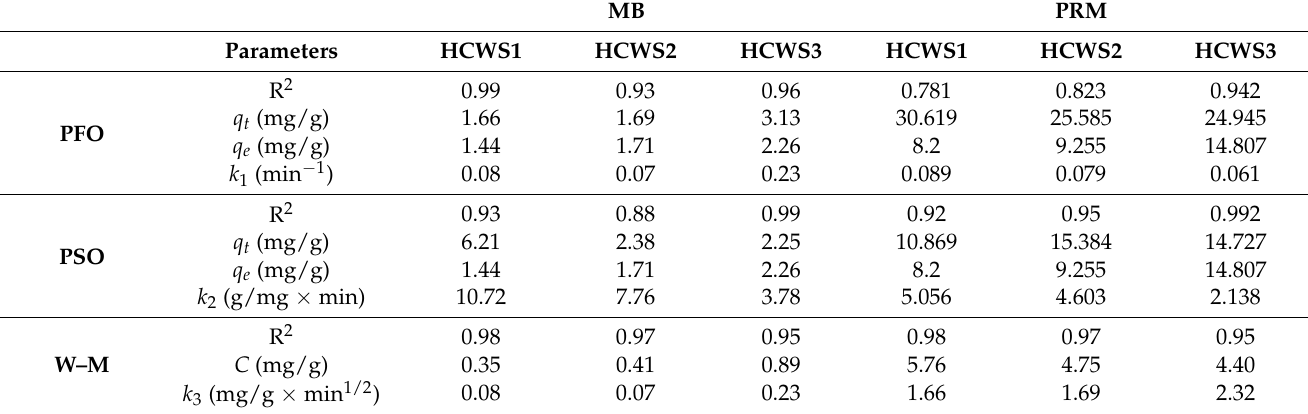
Table 1. Kinetic parameters for MB and PRM retention while using the WS-derived HCs.